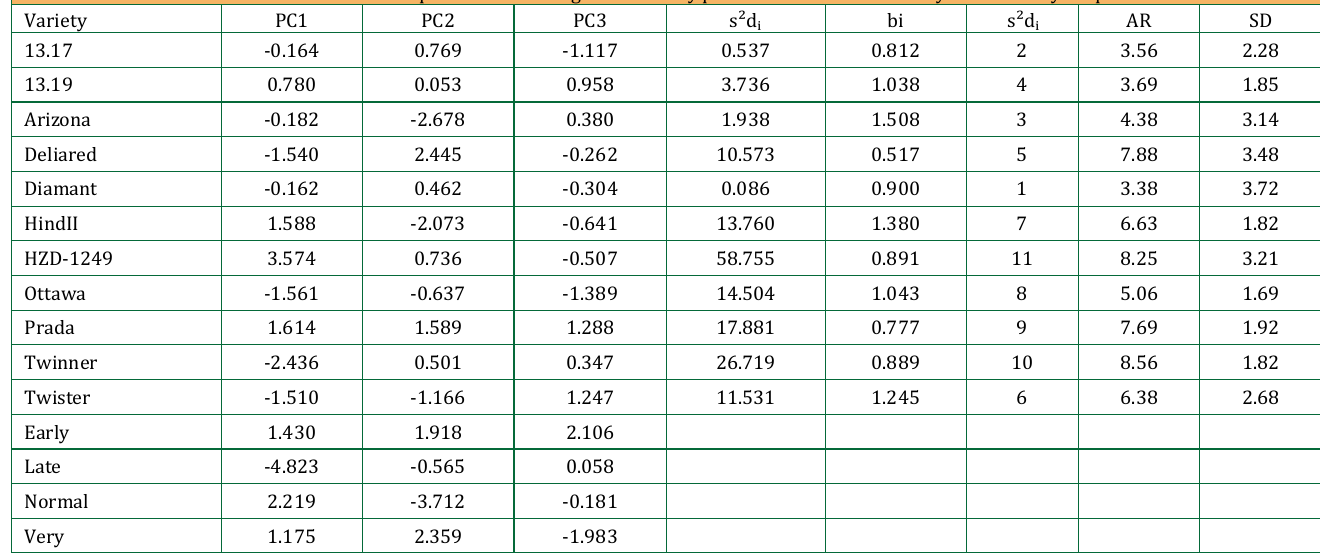
Table 4: Environment wise performance along with stability parameters for marketable yield at 90 days in potato Variety